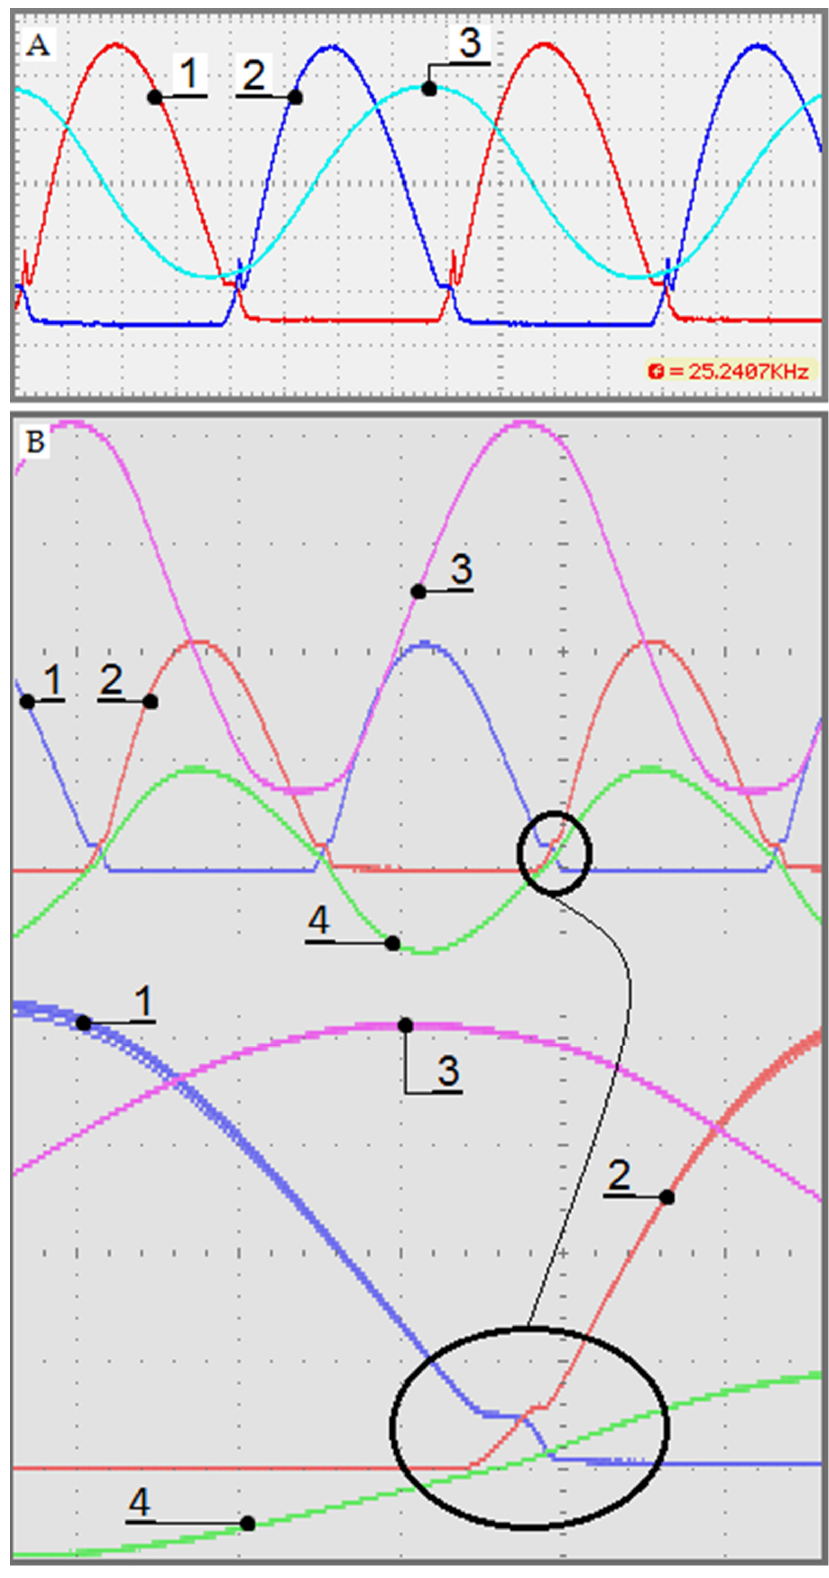
Figure 9. Operation of the inverter for induction heating. ( A , B ) 1, 2—voltages, respectively, over the paralleled high side (Q1, Q3, Q5, Q7—Figure 1) and low side (Q2, Q4, Q6, Q8—Figure 1) transistors; 3—current through the inductor; ( B ): 4—voltage crossing the zero switching point.